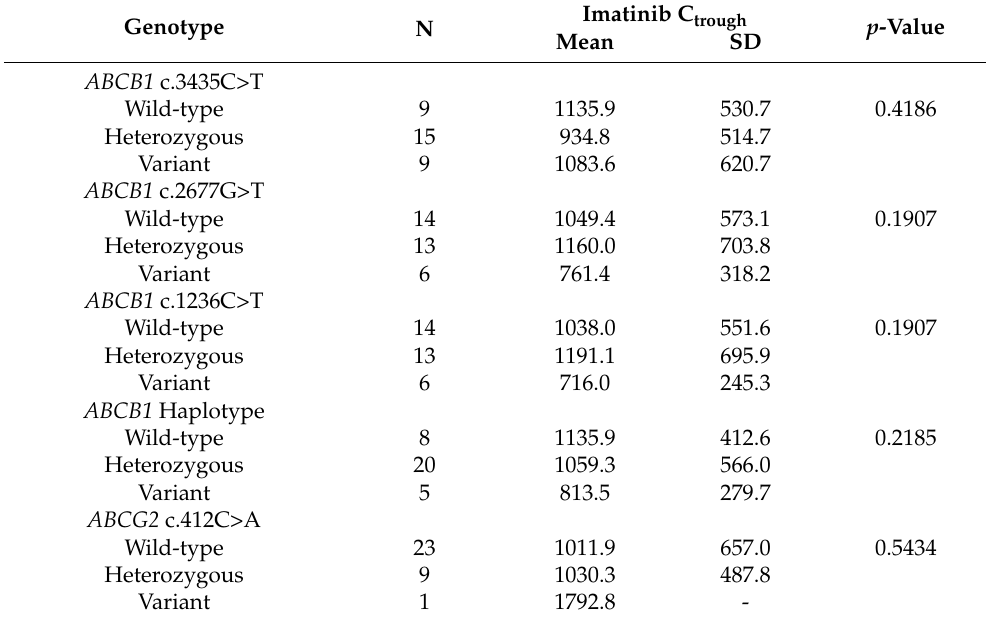
Table 3. Comparison of imatinib C trough with the transporter genotype in CRO-Aviano